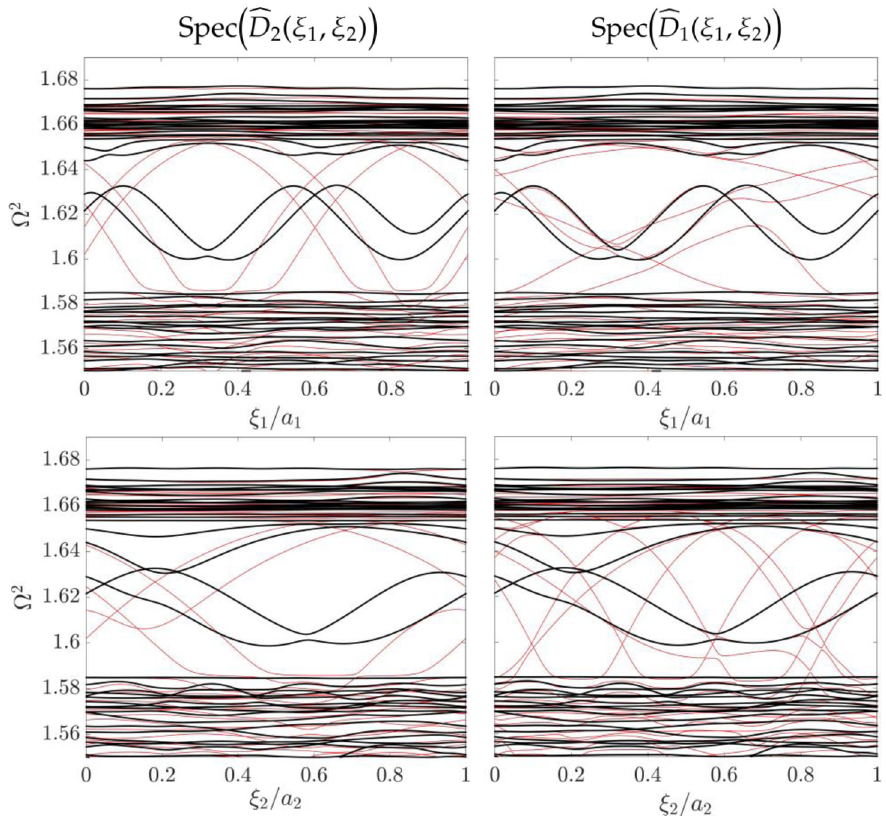
ffiffiffi ffiffiffi p p ; a ; a = Ω 2 ) as a 7 2 ½ 4 (cid:3) 1 ¼ 1 2 ¼ 1. Eigenvalues (